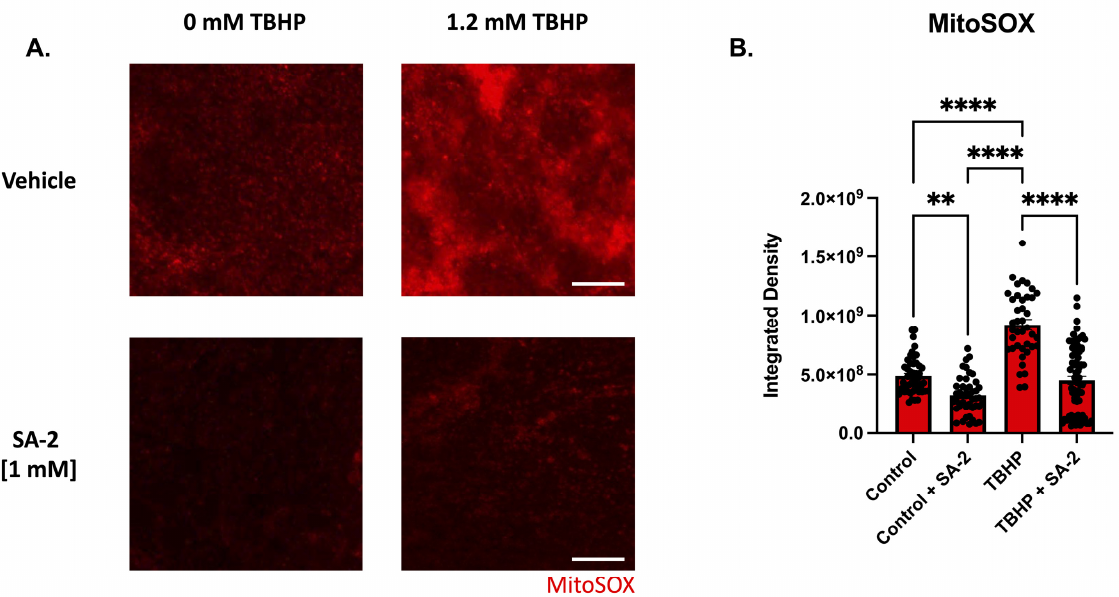
Figure 4. TBHP-mediated oxidative stress in retinal explants from adult Sprague Dawley rats. ( A ) Representative images of superoxide formation stained with MitoSOX™ following 2 h of treat- ment with control [0 mM] and [1.2 mM] TBHP in the presence of either vehicle (DPBS) or SA-2 [1 mM]. The scale bar represents 100 µ m. ( B ) Graph bars demonstrate a decrease in mitochondrial stress amount quantified by MitoSOX™ integrated density in the SA-2 treated groups compared to the vehicle-treated groups (control (0 mM TBHP): 33.74% decrease, p < 0.01; TBHP (1.2 mM): 51.1%, p < 0.0001) using Kruskal–Wallis followed by Dunn’s multiple comparisons. Data represent the mean ± SEM (n = 3 biological replicates, 2–4 explants/group). ** p < 0.01, **** p < 0.0001.